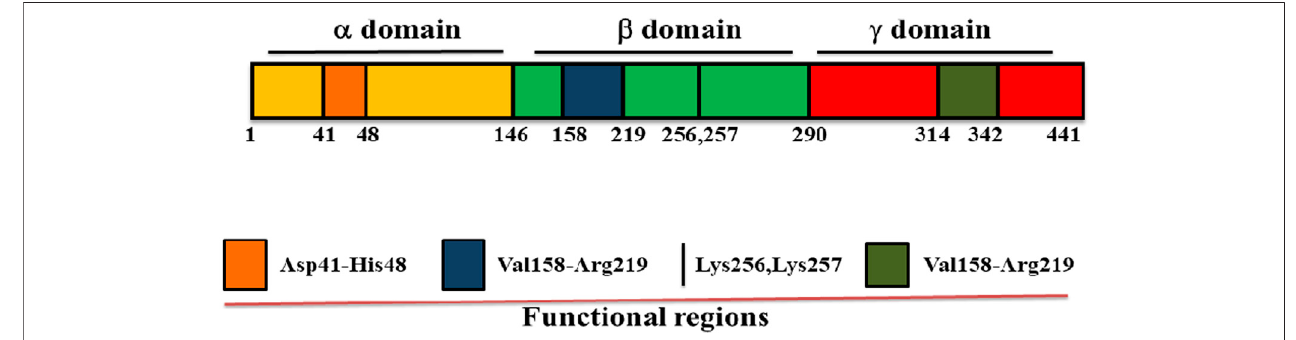
FIGURE1| Domainstructureofstreptokinase.Streptokinaseconsistsofthreedomains: α domainat1 – 146, β domainat147 – 290,and γ domainat291 – 414ofthe amino acid positions. It also contains many functional regions across the domain such as Asp41 – His48 region between the fi rst to 59th 59 amino acid residues of α domain, Lys256, Lys257, and Val158 – Arg219 region of β domain, as well as Leu314 – Ala342 region of γ